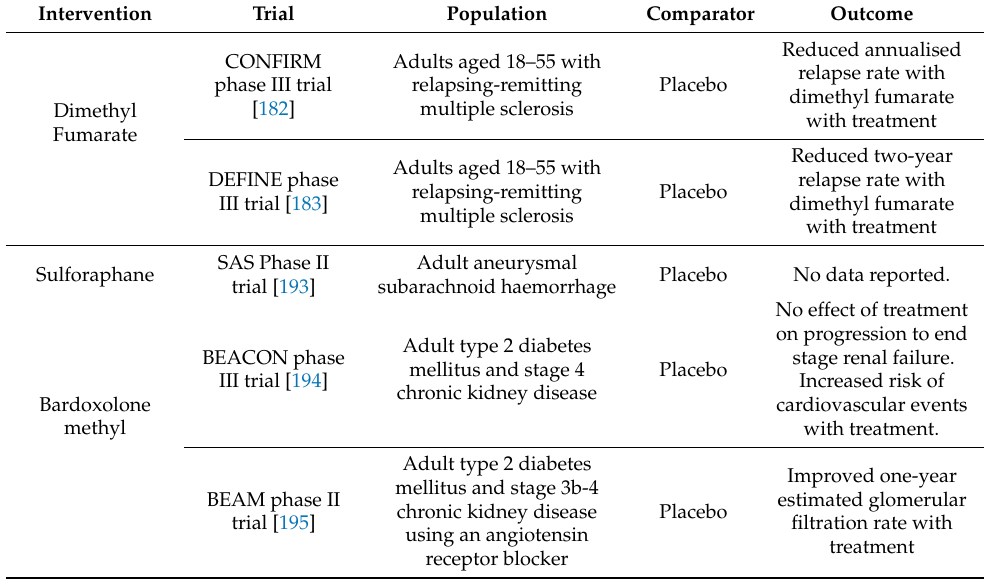
Table 3. Key randomised controlled trials of Nrf2 activators in